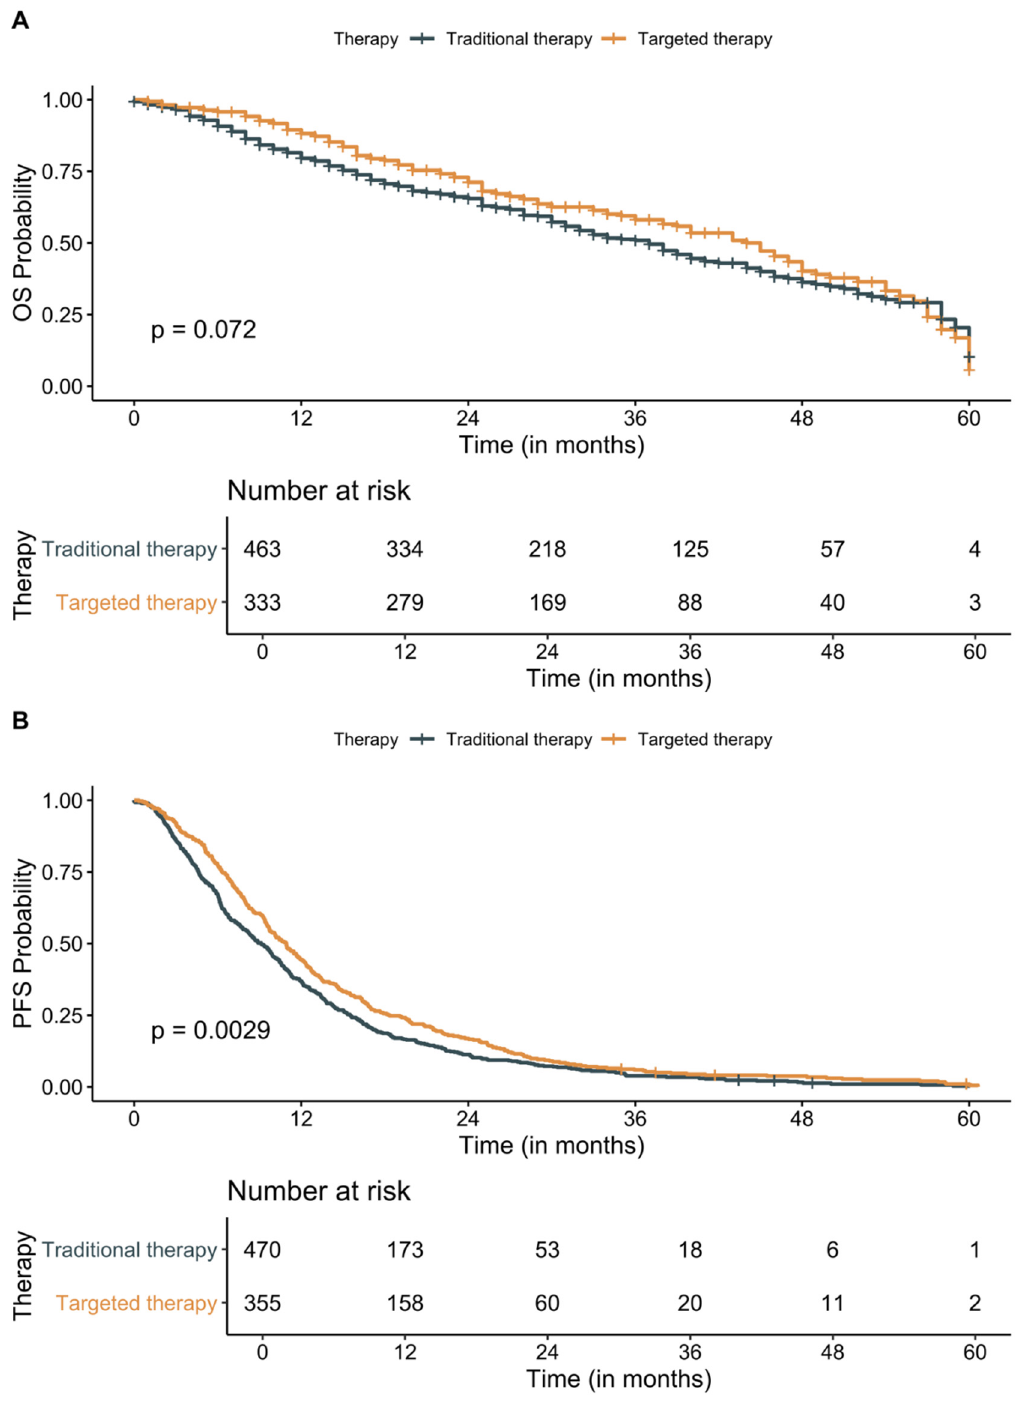
Figure 5. Kaplan–Meier 5-year ( A ) overall survival (OS) and ( B ) progression-free survival (PFS) analysis based on targeted versus traditional therapy use in solid pan-caner metastatic patients. Patients who received targeted therapies as the first-line treatment had improved but not statistically significant improvement in OS compared to patients who did not (median survival 45 months compared to 37 months for patients who received traditional therapies, p = 0.072). However, PFS was significantly improved in patients receiving targeted therapies (median PFS 9.1 months [CI: 8.1–10.1 months] compared to 10.9 months [CI: 9.7–11.9 months] in patients receiving traditional therapies, p = 0.0029). CI: confidence interval.